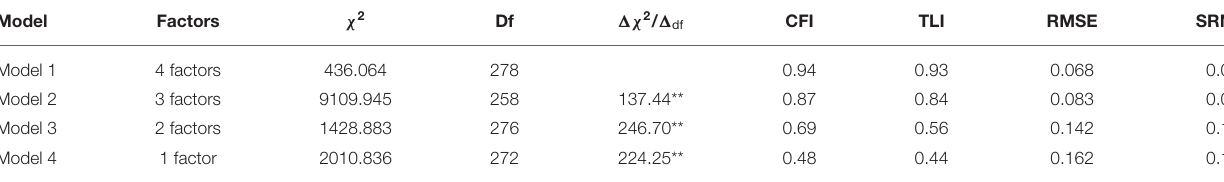
TABLE 1 | Different validity analysis of variables.